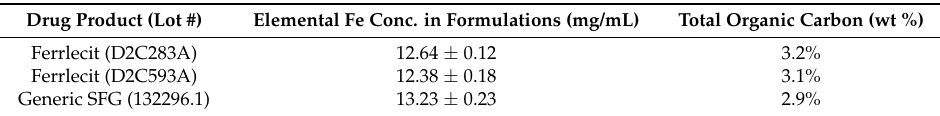
Table 2. Elemental iron and total organic carbon of two Ferrlecit lots (D2C283A and D2C593A) and one generic SFG lot (132296.1).